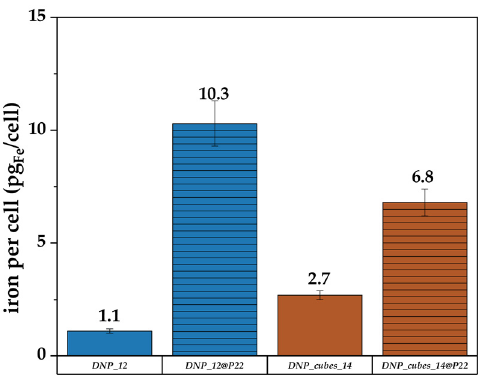
Figure 13. Iron content in FaDu cells determined by the Perls’ Prussian blue colorimetric method after their incubation with DNP_12, DNP_12+P22, DNP_cubes_14, and DNP_cubes_14+P22 for 24 h and at an iron concentration of 100 µg/mL (lined bars = DNP + P22).